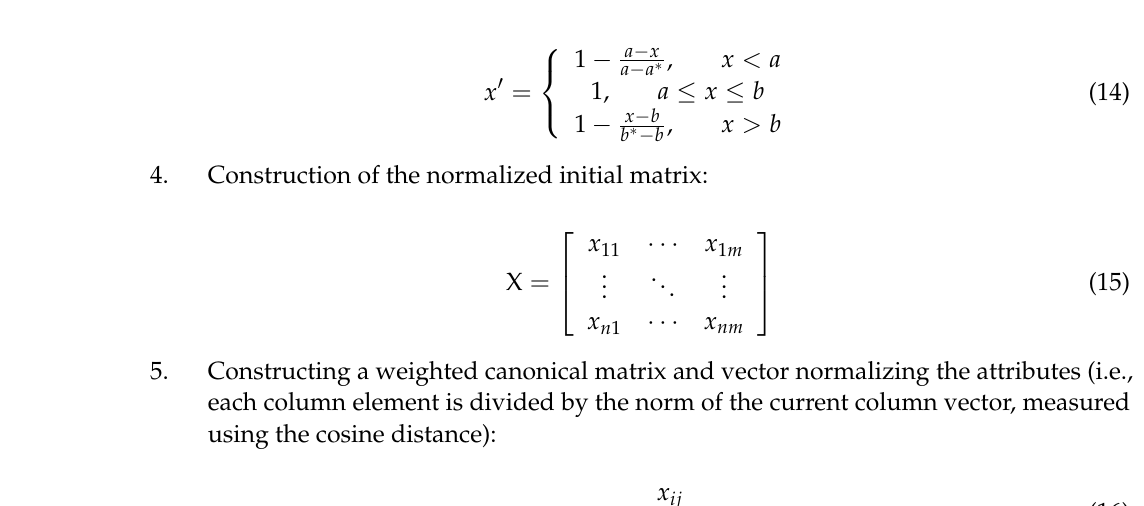
6. Getting the normalized matrix after normalization: